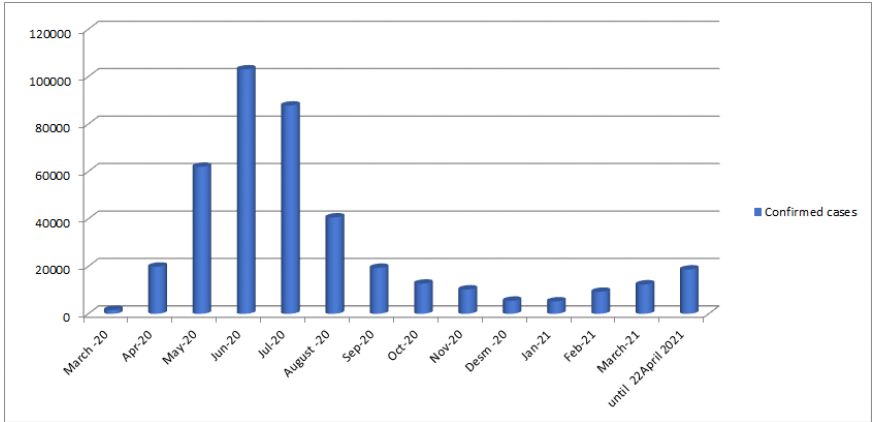
Figure 3. Total confirmed infected cases of COVID-19 in Saudi Arabia for the period from March 2020 to 22 April 2021.